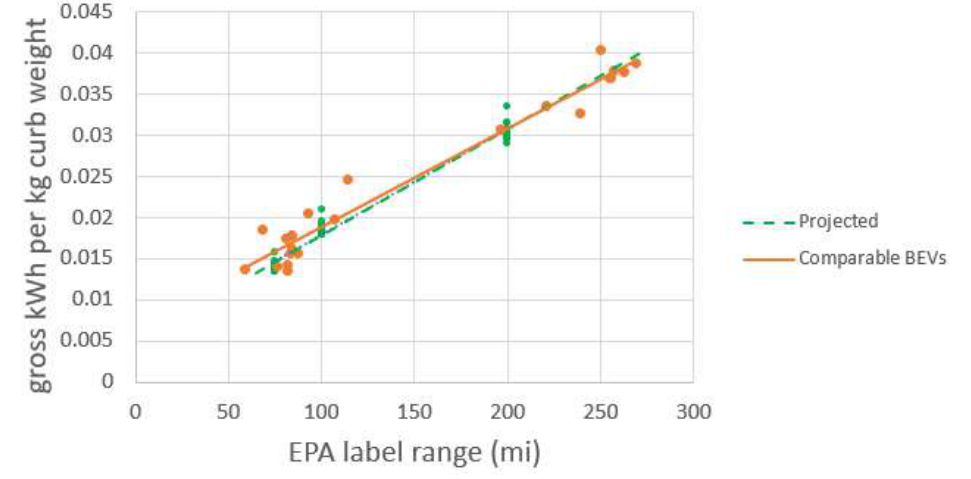
Figure 3. Projected BEV gross battery capacity per unit curb weight compared to comparable production BEVs [3].